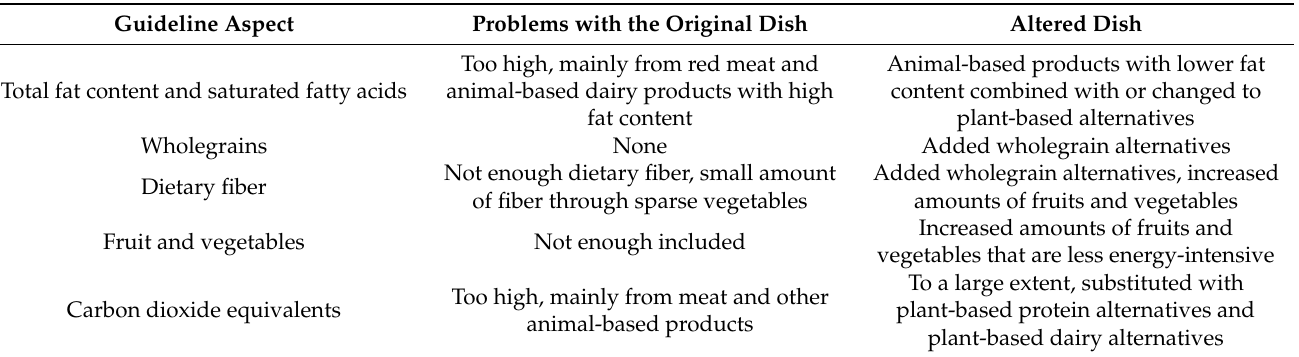
Table 4. The main ingredient changes made from the original dish to the altered one to shape the meals in accordance with the Nordic Nutrition Recommendations [40] and climate impact goals set by the WWF